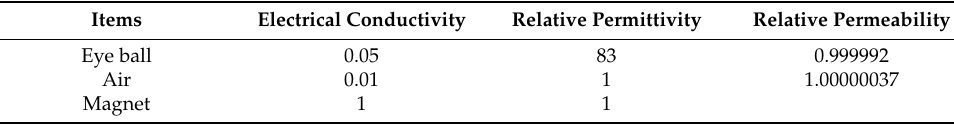
Table 1. Physical properties of each item included in the simulation.